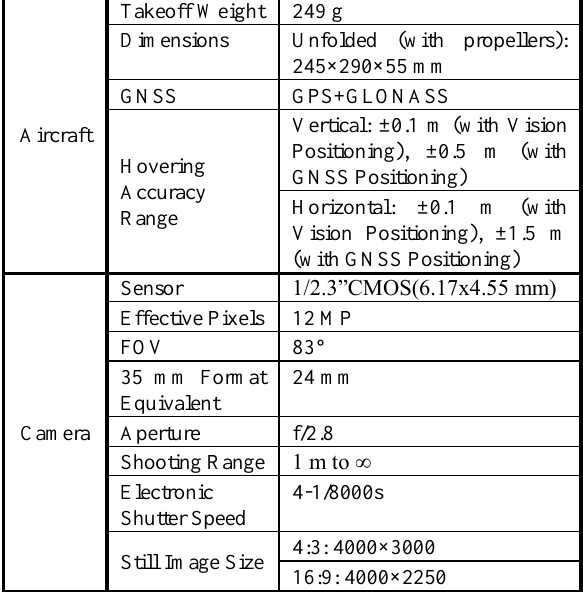
Table 1. DJI Mavic Air